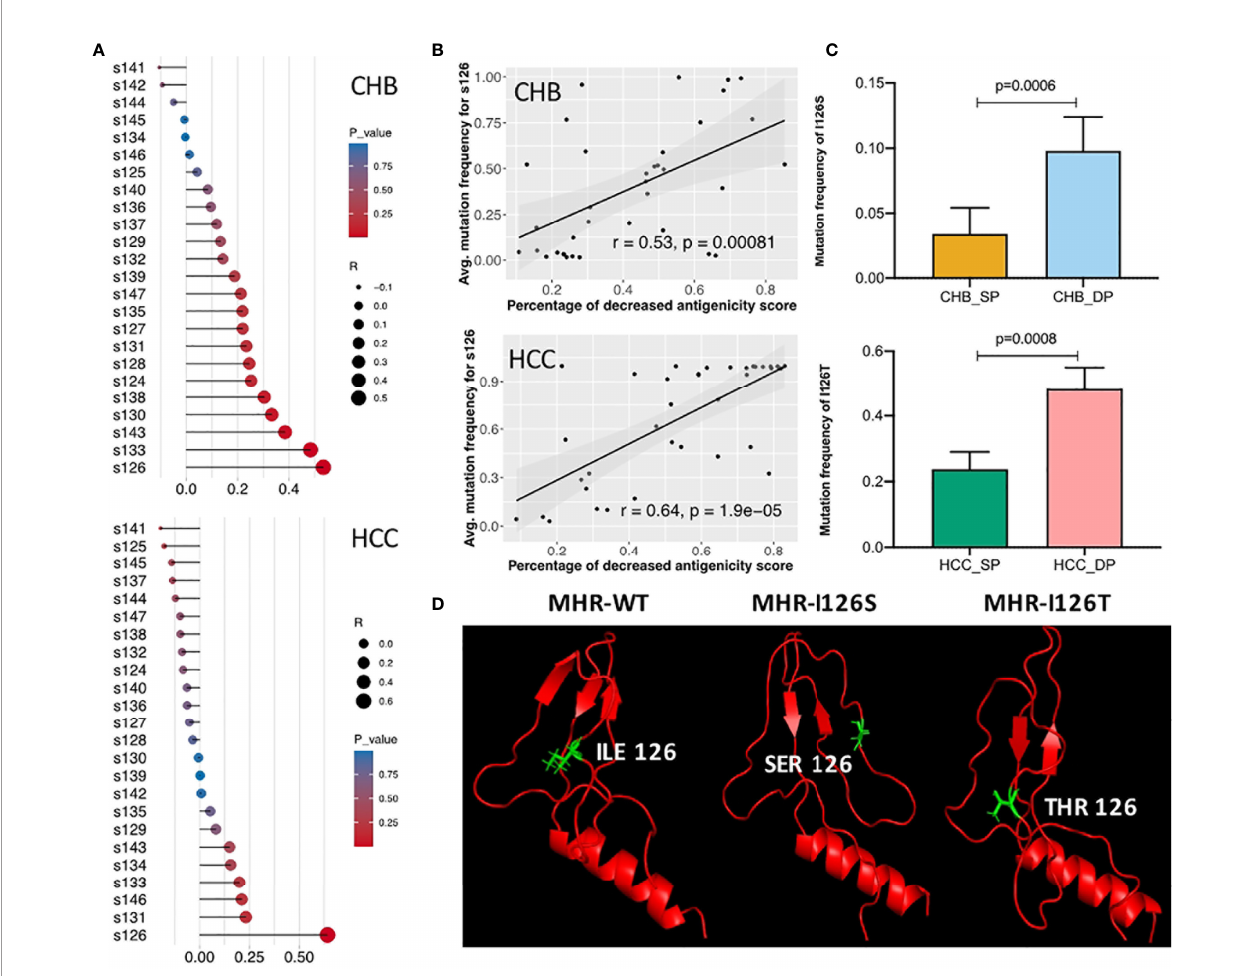
FIGURE 5 | Identi fi cation of different mutation patterns of s126 in double-positive (DP) patients. (A) Correlation analysis among the decreased percentage of antigenicity score (AS) (dp.AS) and mutation frequency of each position in the major hydrophilic region (MHR) A epitope (s124 – 147). The lollipop plot was used to visualize and indicate Spearman ’ s correlation coef fi cient. The length of the line and the size of the circle represent the absolute value of the correlation R, and the color of the circle represents the p-value. (B) High positive correlation was shown between dp.AS in the MHR A epitope and average mutation frequency of position s126 in patients with chronic hepatitis B (CHB) (up) and hepatocellular carcinoma (HCC) (down), respectively. (C) Different mutation patterns of position s126 in patients with CHB (up) and HCC (down). The top histogram plot represents the mutation frequency of I126S in CHB_SP (yellow) and CHB_DP (light blue), and the bottom histogram represents the mutation frequency of I126T in HCC_SP (green) and HCC_DP (pink) patients. Statistical signi fi cance was evaluated using the unpaired Wilcoxon test. (D) Three 3D prediction structures of MHR amino acid residues associated with different mutation patterns of position s126 (left, wild type; middle, I126S; right, I126T). The chains of s126 were labeled as sticks and marked as green